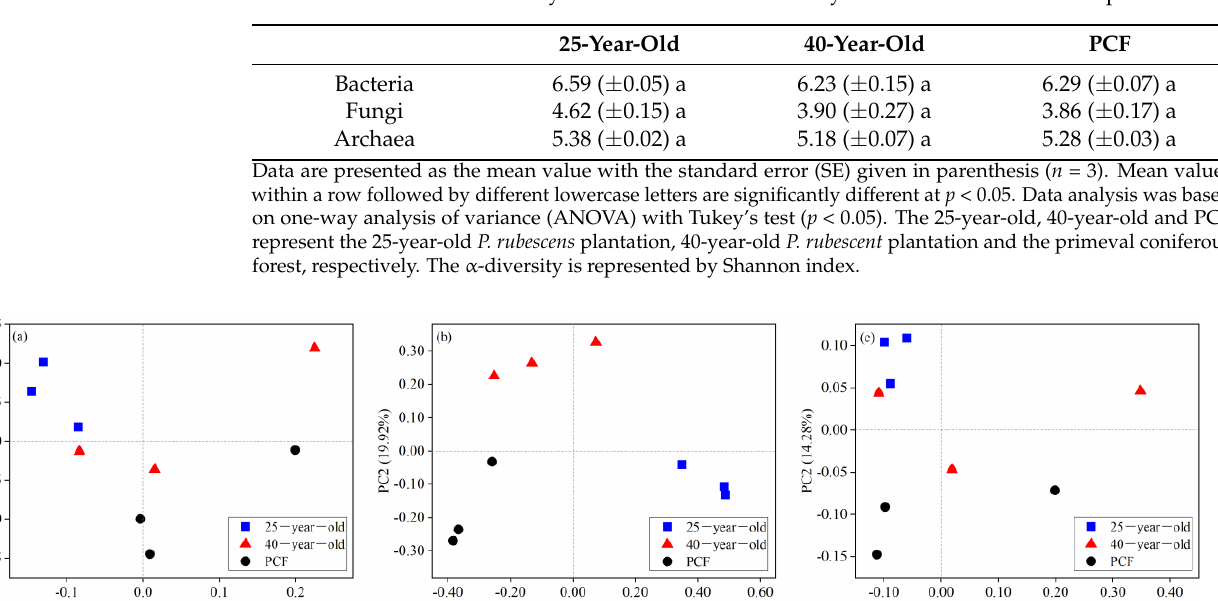
Table 2. Taxonomic α -diversity of the microbial community in the three stands at the species level.